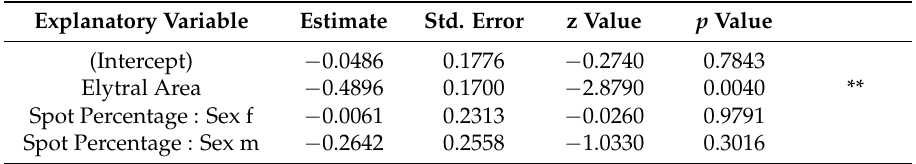
Table 1. Results for the model addressing the prevalence of infection of Ha. axyridis with H. virescens . Explanatory Variable Estimate Std.